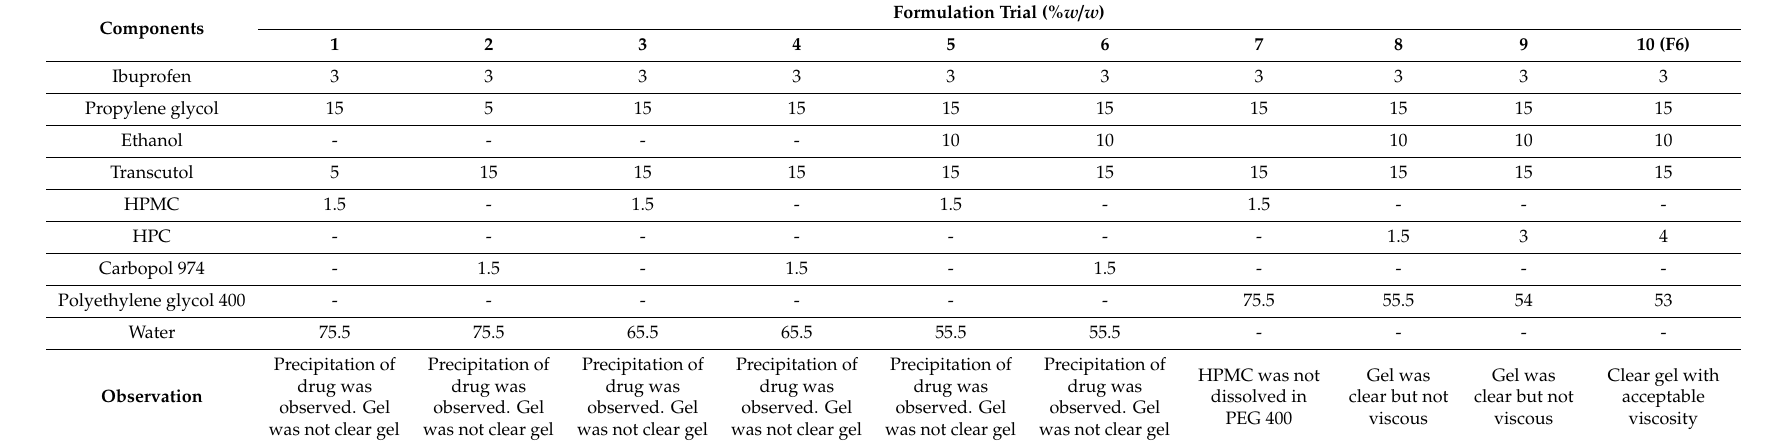
Table A3. Optimization of clear gel